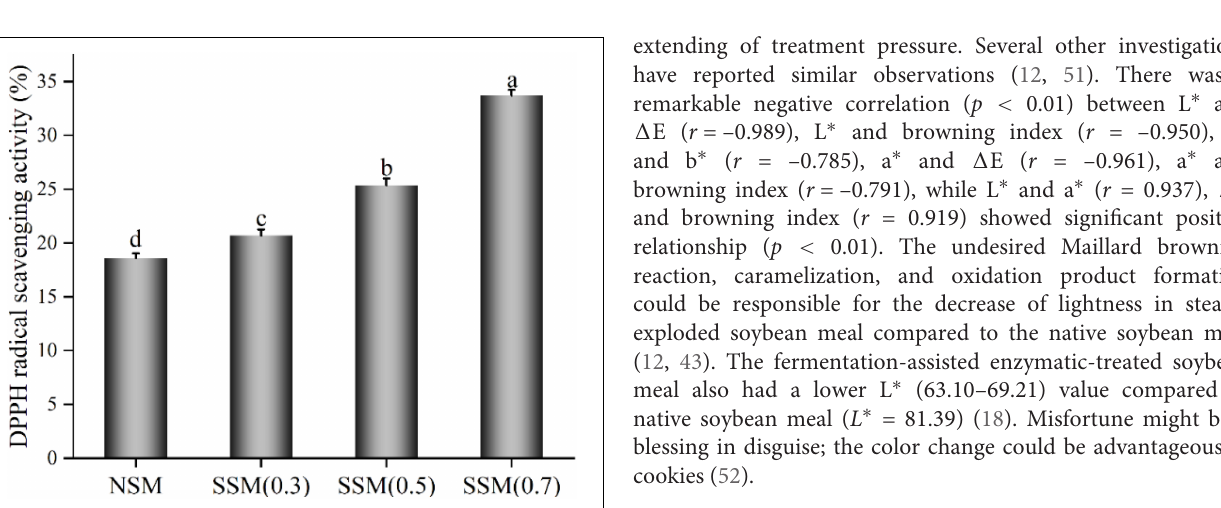
FIGURE 9 | Antioxidant property of soybean meal extract. NSM, native soybean meal; SSM, steam-exploded soybean meal, SSM (0.3), SSM (0.5), and SSM (0.7) indicated steam explosion pressure were 0.3, 0.5, and 0.7 MPa, respectively (means that do not share a letter are significantly different, p <